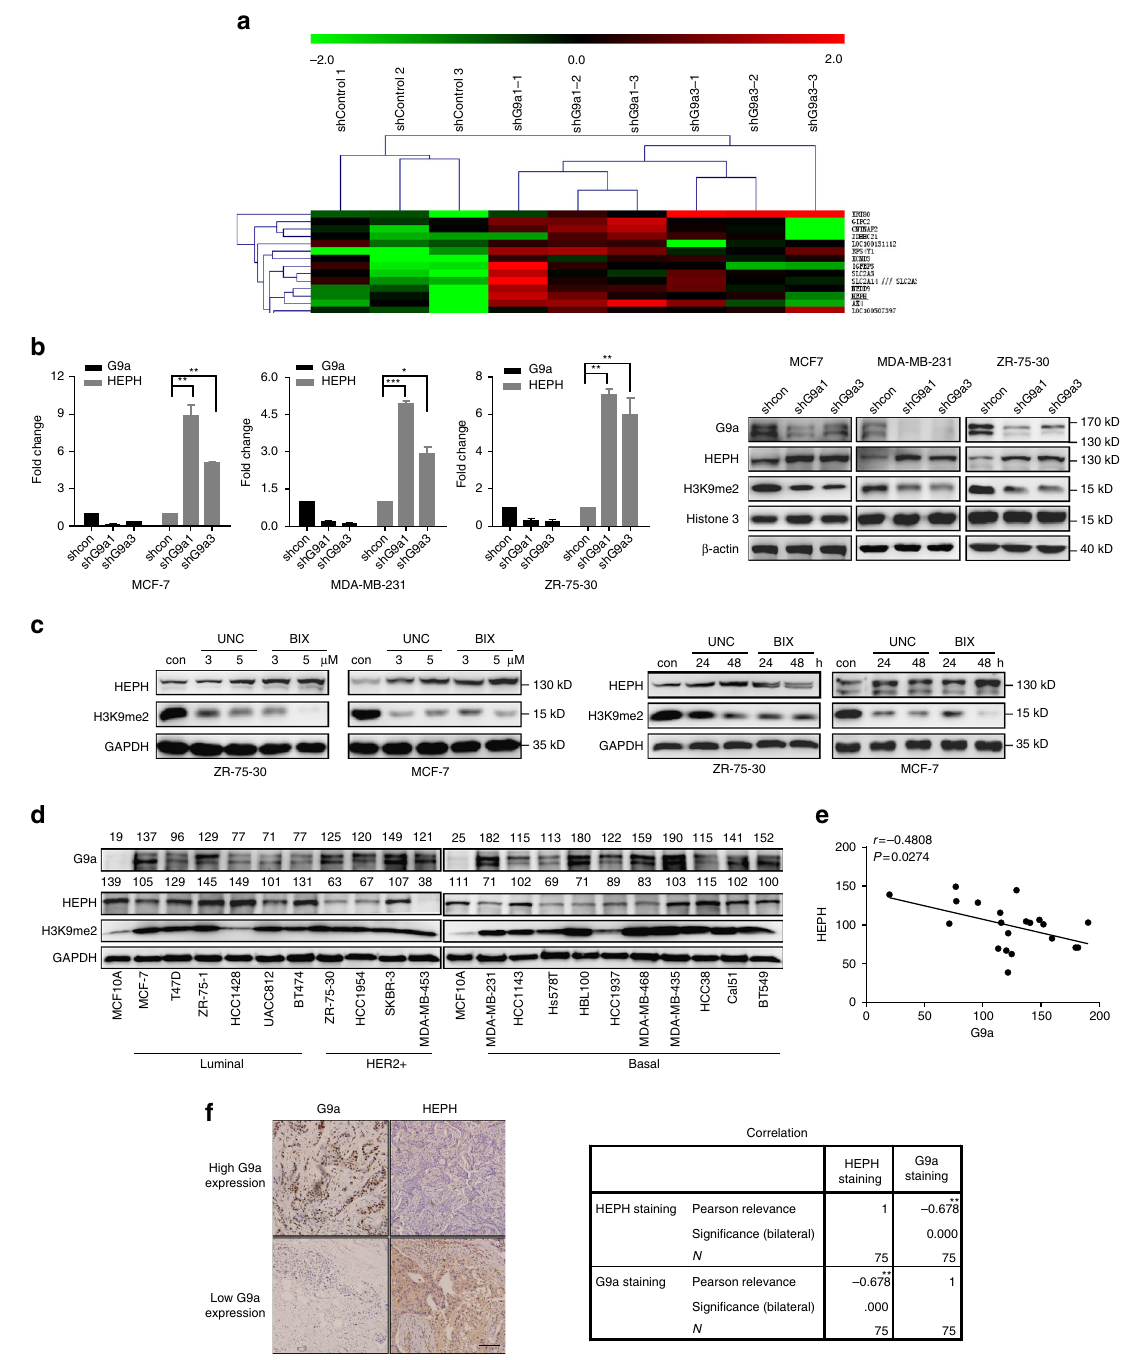
Fig. 2 G9a negatively regulates HEPH expression. a Microarray pro fi ling of gene expression in MDA-MB-231 G9a knockdown cell lines. Heat map values represent the log2 fold change of read counts relative to the counts in the shcontrol cells ( lane 1 – 3 ).Validation of the microarray analysis results by reverse- transcription – PCR and western blotting. Relative HEPH mRNA and protein levels in G9a knockdown b and G9a inhibitor-treated c cell lines were evaluated. The levels of HEPH and G9a expression in human normal mammary epithelial cell MCF10A and twenty breast cancer cell lines were quanti fi ed by Image J d and the correlation between them was analyzed using GraphPad; GAPDH was used as a loading control e . Data represent the mean of three independent experiments. f Immunohistochemical staining analysis of G9a and HEPH proteins in serial sections from breast cancer patients. Pearson ’ s relevance was used to compare G9a and HEPH immunostaining. Note inverse correlation of G9a and HEPH protein expression in tumor cells. Shown are representative sections. Scale bar , 50 μ m. Results are representative of at least three independent experiments compared with the value for the untreated control and are shown as means with SD. Two-tailed unpaired Student ’ s T -test was performed. * P < 0.05, ** P < 0.01 and *** P < 0.001